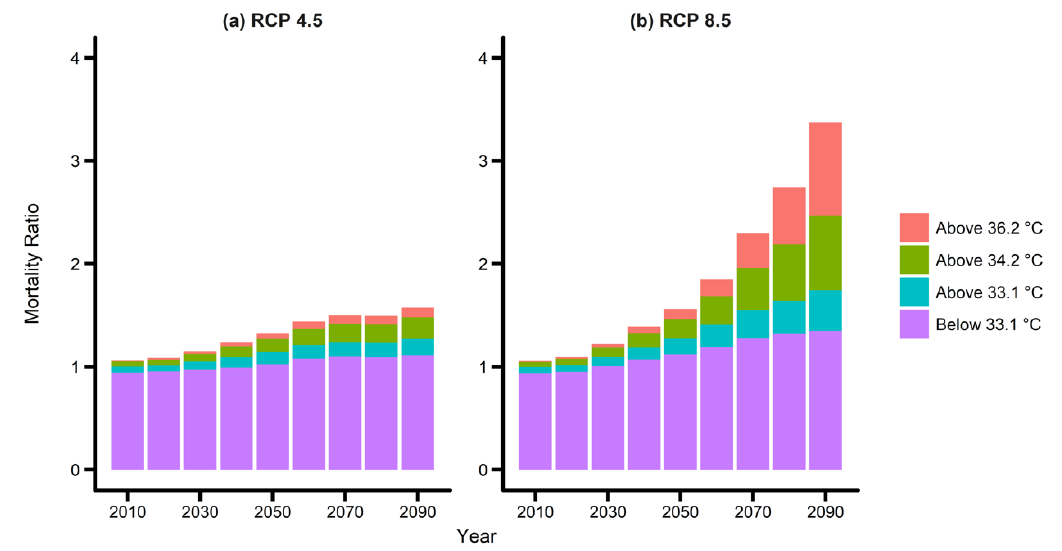
Figure 5. Mortality ratios according to an increased intensities and frequencies of extreme temperatures under: ( a ) RCP 4.5 and ( b ) RCP 8.5. Temperatures of 33.1 ◦ C, 34.2 ◦ C, and 36.2 ◦ C correspond to the 90th, 95th, and 99th percentiles during the baseline period. RCP, Representative Concentration Pathway.